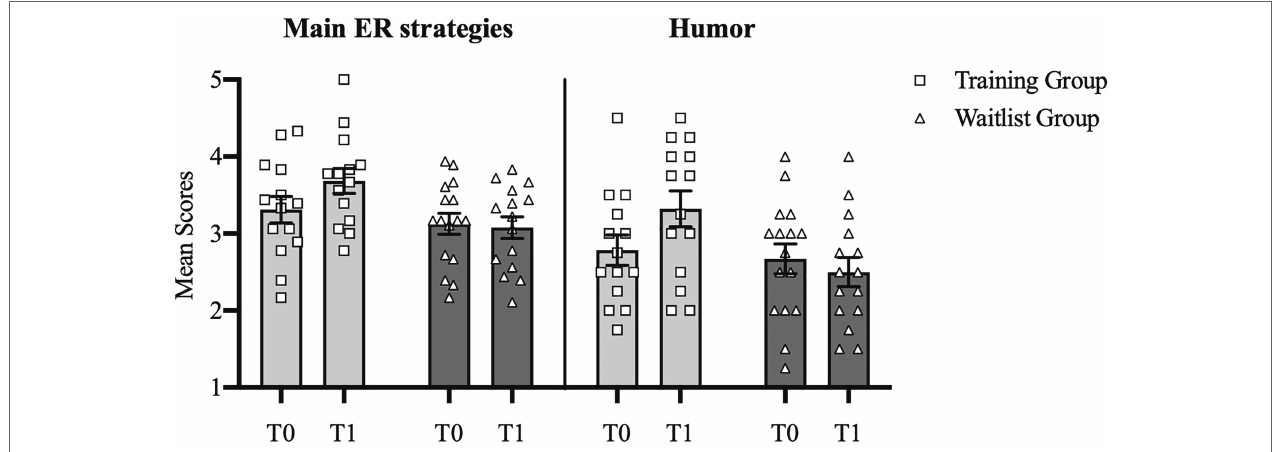
FIGURE 3 | Mean scores of self-reported use of main ER strategies and humor in training versus waitlist group. Error bars represent standard